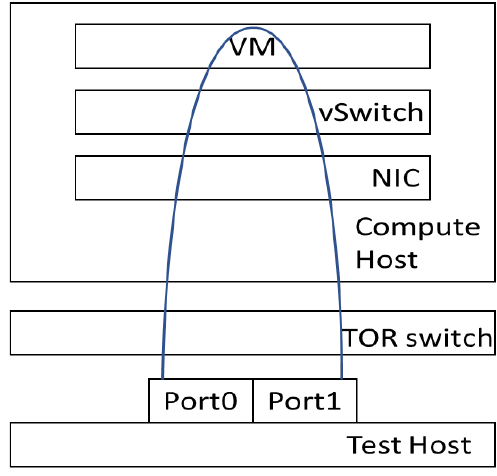
Figure 6. Packet path in PVP scenario .